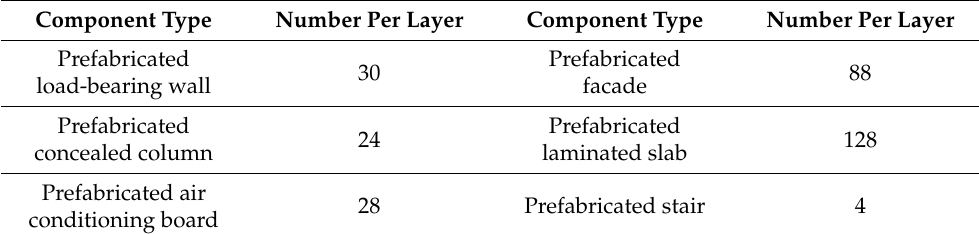
Table 7. Types of components and their numbers for each standard